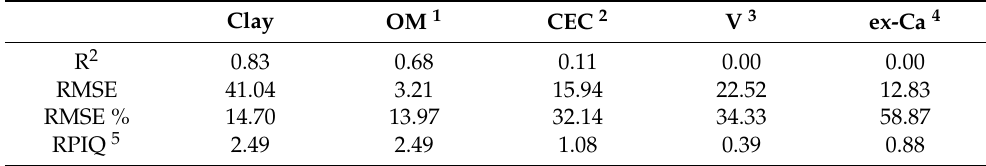
Table A1. Prediction results of the independent test set obtained from artificial neural network (ANN) models calibrated using mobile visible and near-infrared spectroscopy